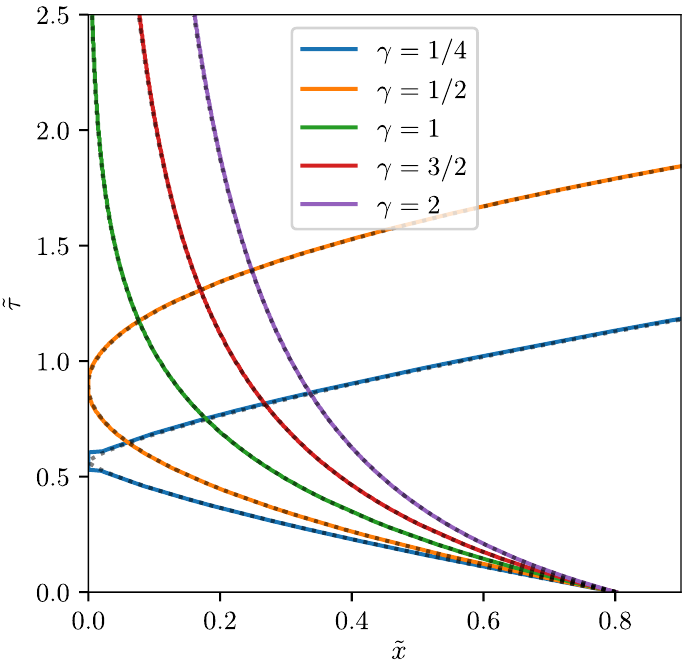
Figure 3: Peak position as a function of time for Gaussian wave packets in the lattice = 0.8, p = π/ 2, ˜ w = 0.05, and lattice of size model, for five values of γ and using ˜ x 0 0 N = 1001. The solid lines represent numerical calculations, while the dashed lines represent the solution of Eq. (37). For γ < 1, the wave packet bounces on the origin of the lattice, while for γ ≥ 1, it asymptotically reaches the origin of the